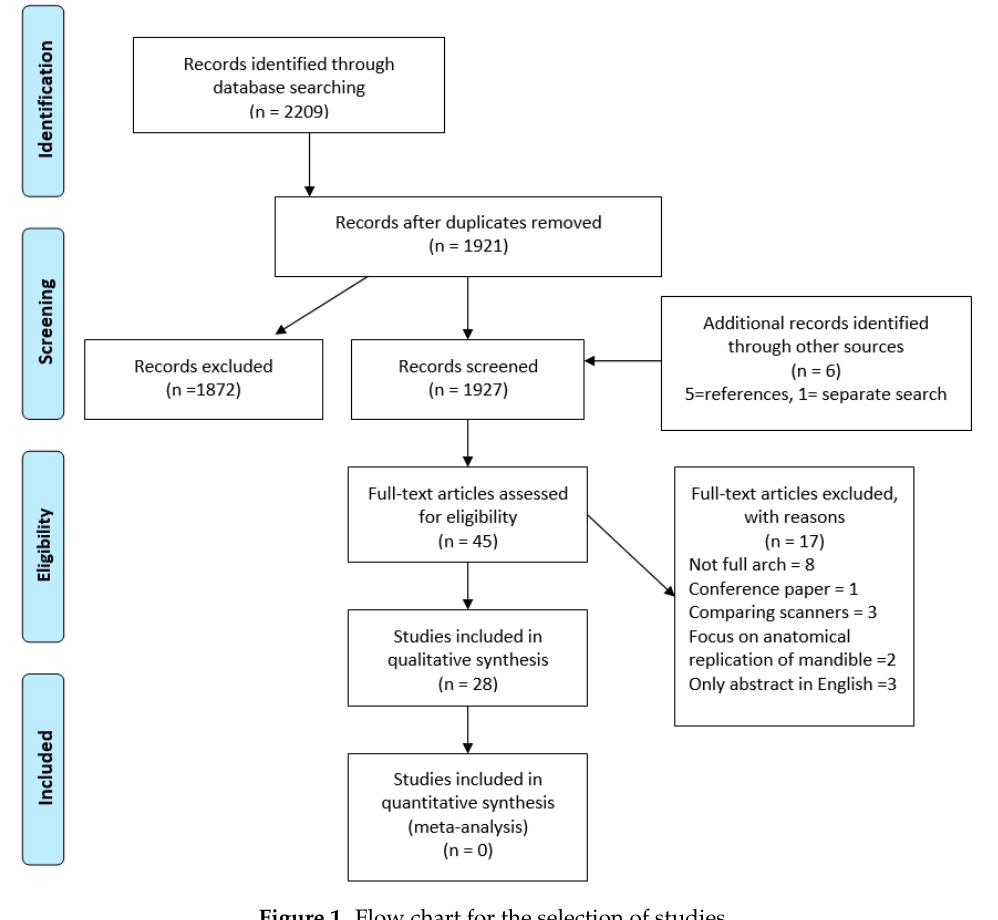
Figure 1. Flow chart for the selection of studies.